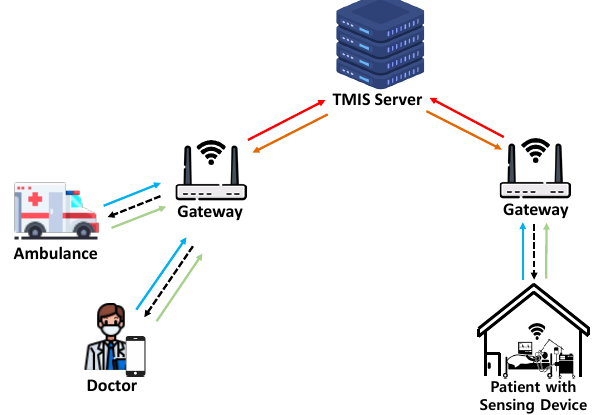
Figure 1. TMIS network model.